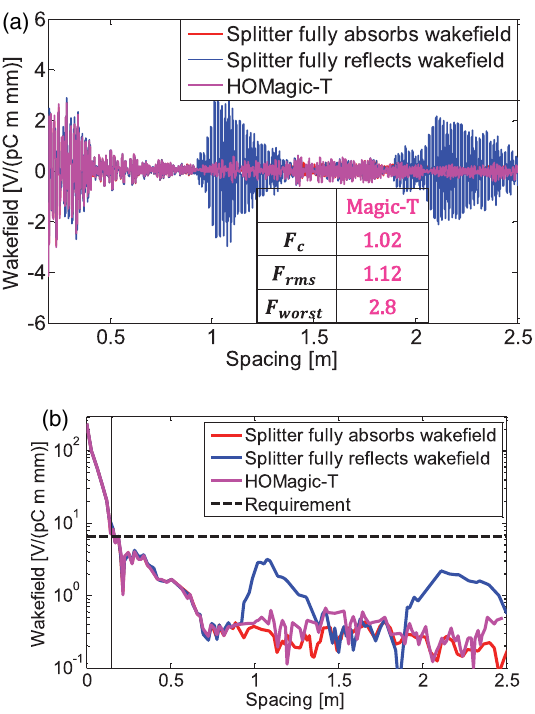
FIG. 27. Geometry of the special HOMagic-T design (top: view of vacuum part; bottom: view of metal part).